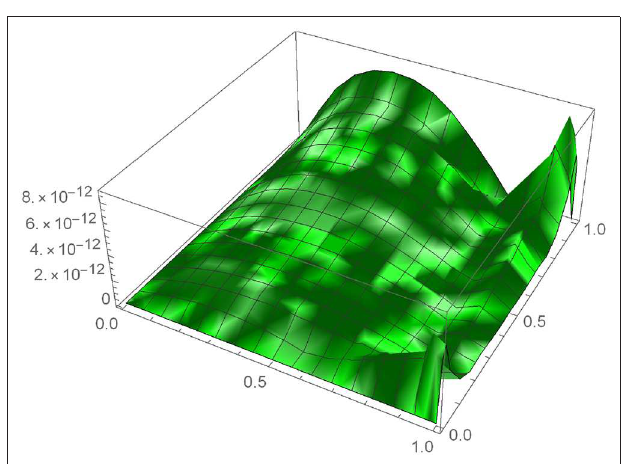
FIGURE 5 | Variation of u for α = 0.9, m = 4, and t = 0.1 in case when time-fractional derivative is of Caputo Fabrizio and Caputo type.